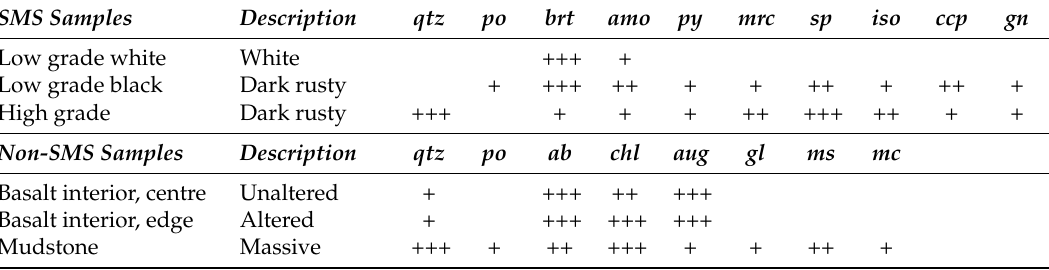
Table A2. Mineralogy of samples after XRD analysis, reproduced with permission [31]. In this table + is 0–5%, ++ is 5–5%, +++ is 15% and above. Mineral abbreviations after